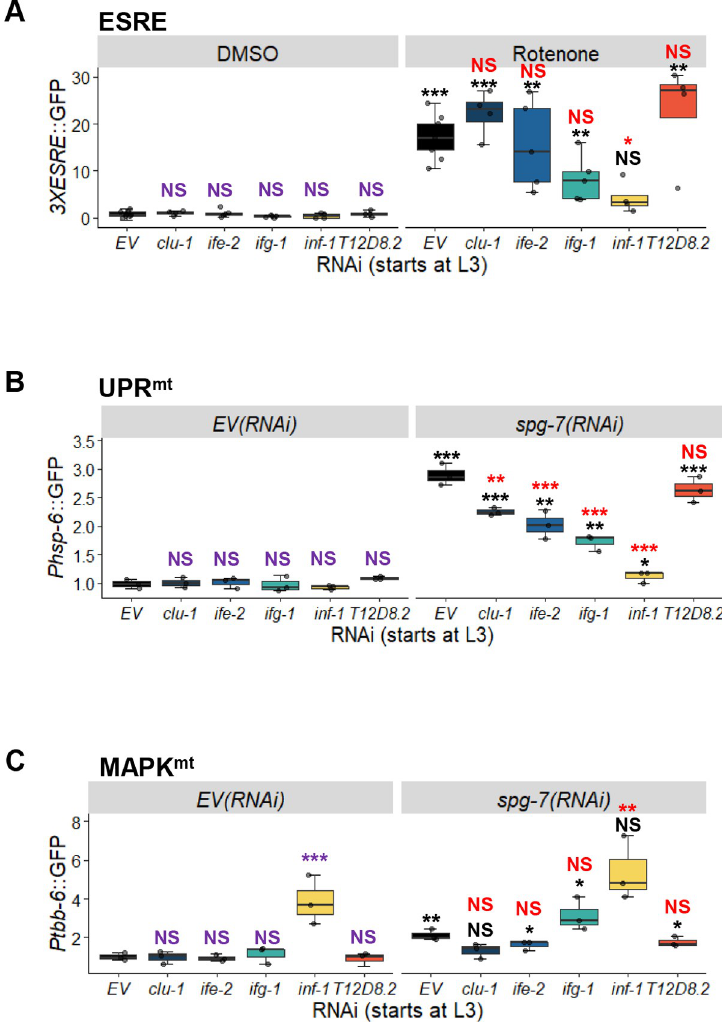
Fig 5. Blocking translational initiation generally does not diminish activation of mitochondrial surveillance pathways. Quantification of GFP fluorescence of C . elegans carrying 3XESRE ::GFP (A) , Phsp-6 ::GFP (B) , or Ptbb-6 :: GFP (C) reporters that were reared on E . coli expressing empty vector ( EV ) or RNAi targeting the eukaryotic initiation factors clu-1/eIF3A , ife-2/eIF4E , ifg-1/eIF4G , inf-1/eIF4A , or T12D8 . 2/eIF4H . (A) Worms were treated for 8 hours with vehicle (DMSO) or 50 μ M rotenone. (B, C) Worms were stressed with spg-7(RNAi) , and an empty vector ( EV ) control was included. Three biological replicates with ~400 worms/replicate were analyzed. p -values were determined from two-way ANOVA, followed by Dunnett’s test, or Student’s t -test. All fold changes were normalized to DMSO- EV or EV control. NS not significant, � p < 0.05, �� p < 0.01, ��� p < 0.001. In all panels, purple significance marks indicate comparison between gene(RNAi) and EV(RNAi) in unstressed condition (DMSO or EV(RNAi) ), red marks indicate comparison between gene(RNAi) and EV(RNAi) in stressed condition (rotenone or spg-7(RNAi) ), and black marks indicate comparison between stressed and unstressed conditions. Worms carrying the Pirg-5 ::GFP reporter were reared on either empty vector or RNAi tar- geting components of the box C/D snoRNP complex, and then GFP expression was evaluated in young adults. Interestingly, this disruption activated irg-5 more strongly than P . aeruginosa infection on agar in empty vector controls ( Fig 6B ). It is also worth noting that infecting worms with fib-1(RNAi) or nol-58(RNAi) with P . aeruginosa did not further increase GFP expression compared to uninfected counterparts, suggesting that irg-5 induction may have already been maximized.